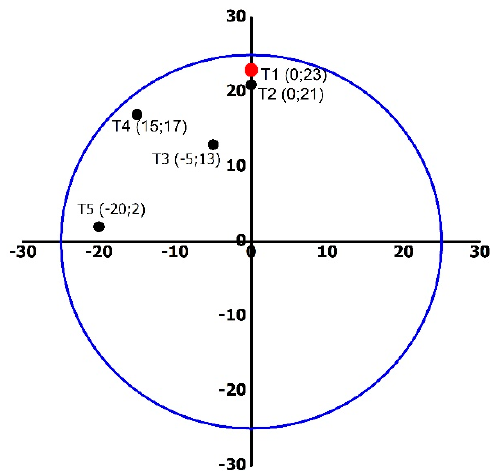
Figure 4. Position of the probes in the plate (cm). Probes are indicated by the letter T and are positioned in the plate according to the axes X and Y drawn on the plate. T1 is positioned above the burner. T2, T3, T4 and T5 have the following coordinates respectively (0; 21), ( − 5; 13), ( − 15; 17) and ( − 20; − 2).